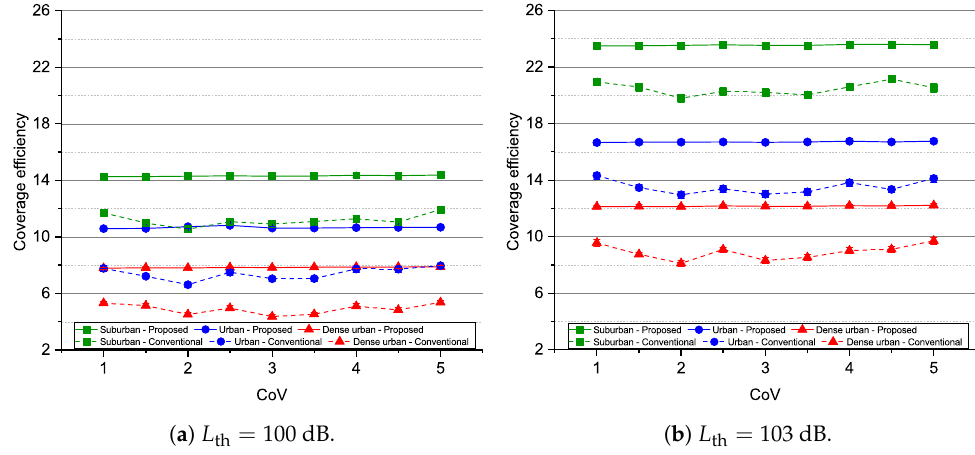
Figure 6. Coverage efficiency versus CoVs for different urban environments and threshold path losses.